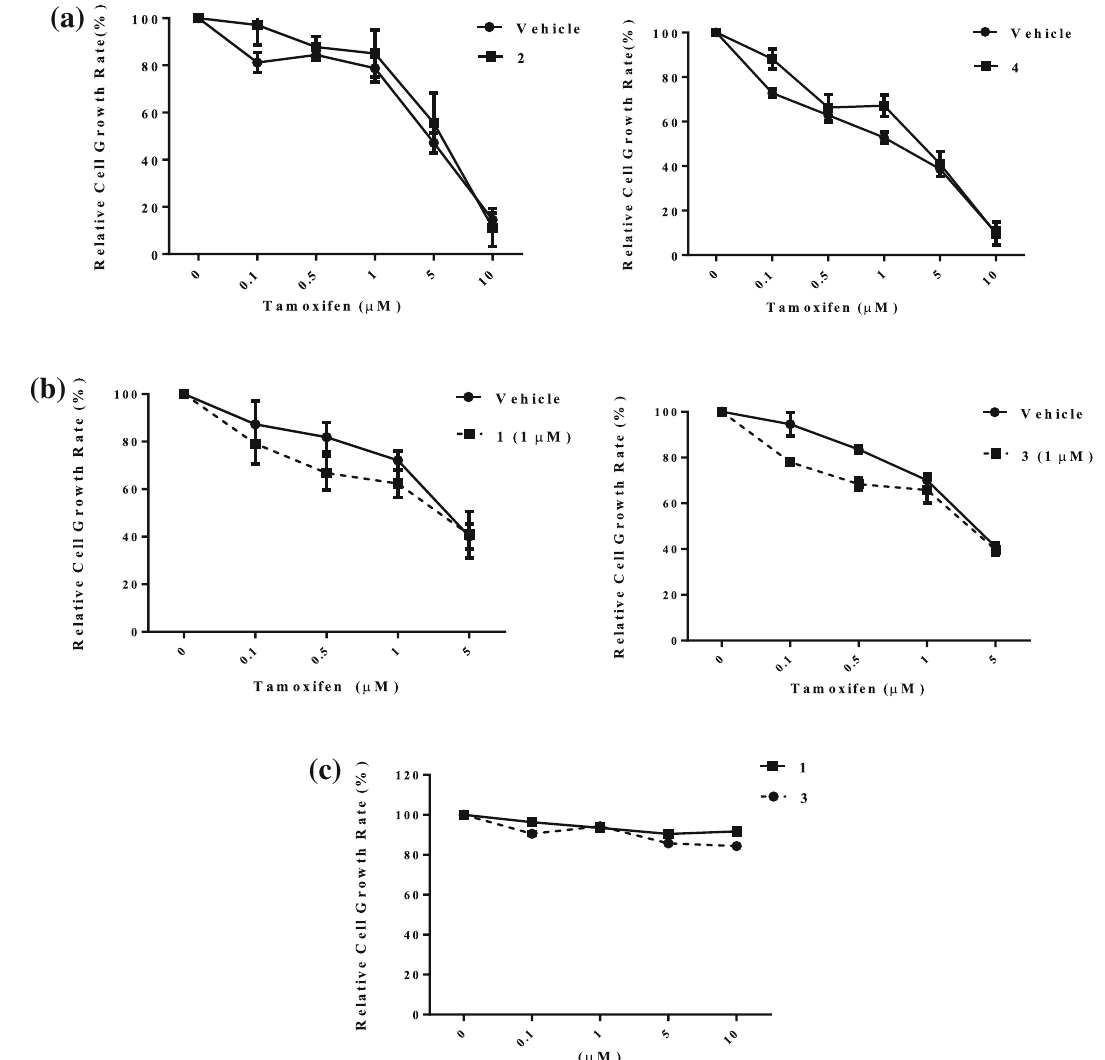
Fig. 4 Effect of compounds 1 – 4 on cell growth and tamoxifen resistance in MCF-7/TamR. a Relative cell growth rate of MCF-7/ TamR cells was tested with different doses of tamoxifen under the concentrations of 10, 15, and 20 l M of 2 ( left ) and 4 ( right ). b Relative cell growth rate of MCF-7/TamR cells was tested with